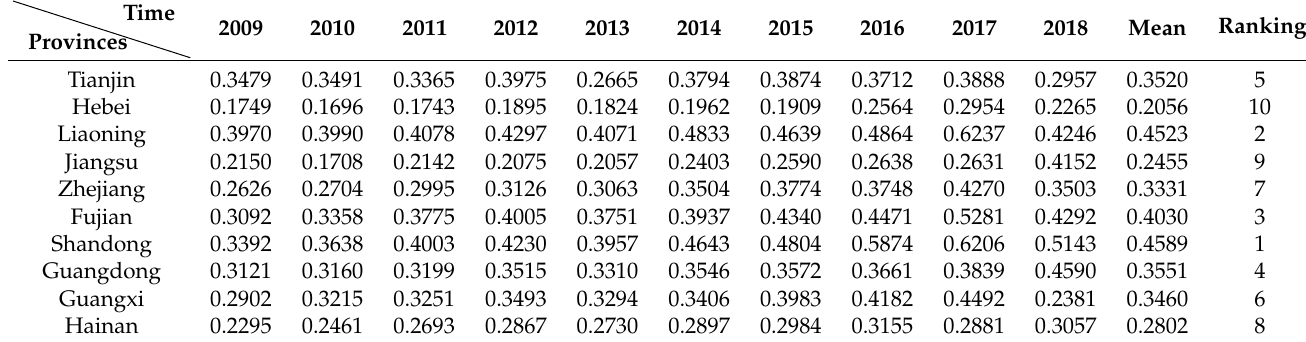
Table 2. Marine fisheries development level in China’s coastal